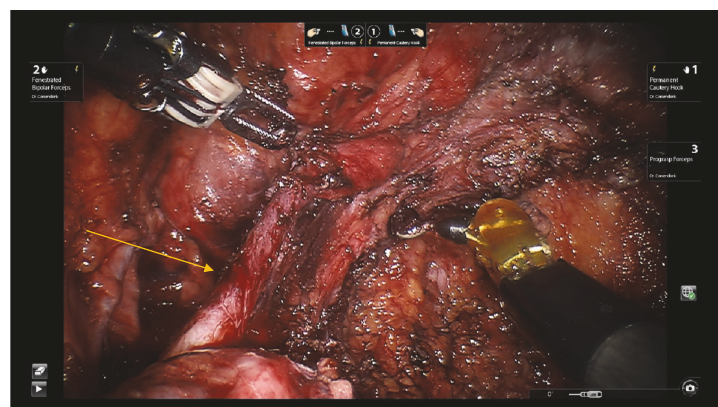
Figure 1: Intraoperative finding of left ureteral injury with subserosal hematoma (yellow arrow).